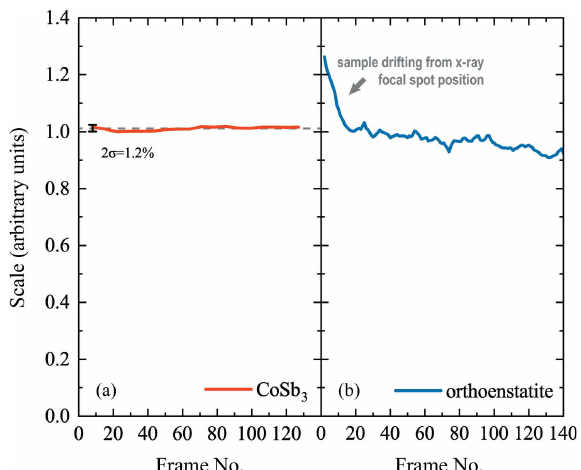
Figure 7 The output of the SCALE3 ABSPACK empirical absorption correction routine of CrysAlis PRO , indicating the amount of scaling which had to be applied to each frame in order to compensate for the intensity mismatch between different Friedel equivalents. Each frame corresponds to a physical angle with a step size of 0.5 (cid:3) per frame. ( a ) The flat red line with 2 (cid:2) = 1.2% is attributed to an average value of 1.011 (gray dashed line). It indicates the excellent stability of the CoSb 3 sample with respect to the X-ray beam during single-crystal data acquisition. ( b ) Our analysis shows that the orthoenstatite single crystal was moving slightly out of the X-ray beam in the angular range corresponding to frame Nos. 0–20. We consider that the centering procedure involving the gasket absorption profile combined with visible light observations was not perfect enough. The difference in point scatter between the red and blue lines can be attributed to the difference in scattering factors. For the data in panel ( a ) we had to use a 50 m m Pt absorber foil in order to reduce the intensity of the diffraction signal coming from the sample. The much stronger scattering from CoSb 3 than from orthoenstatite is the reason for the noise difference between the red and blue curves.